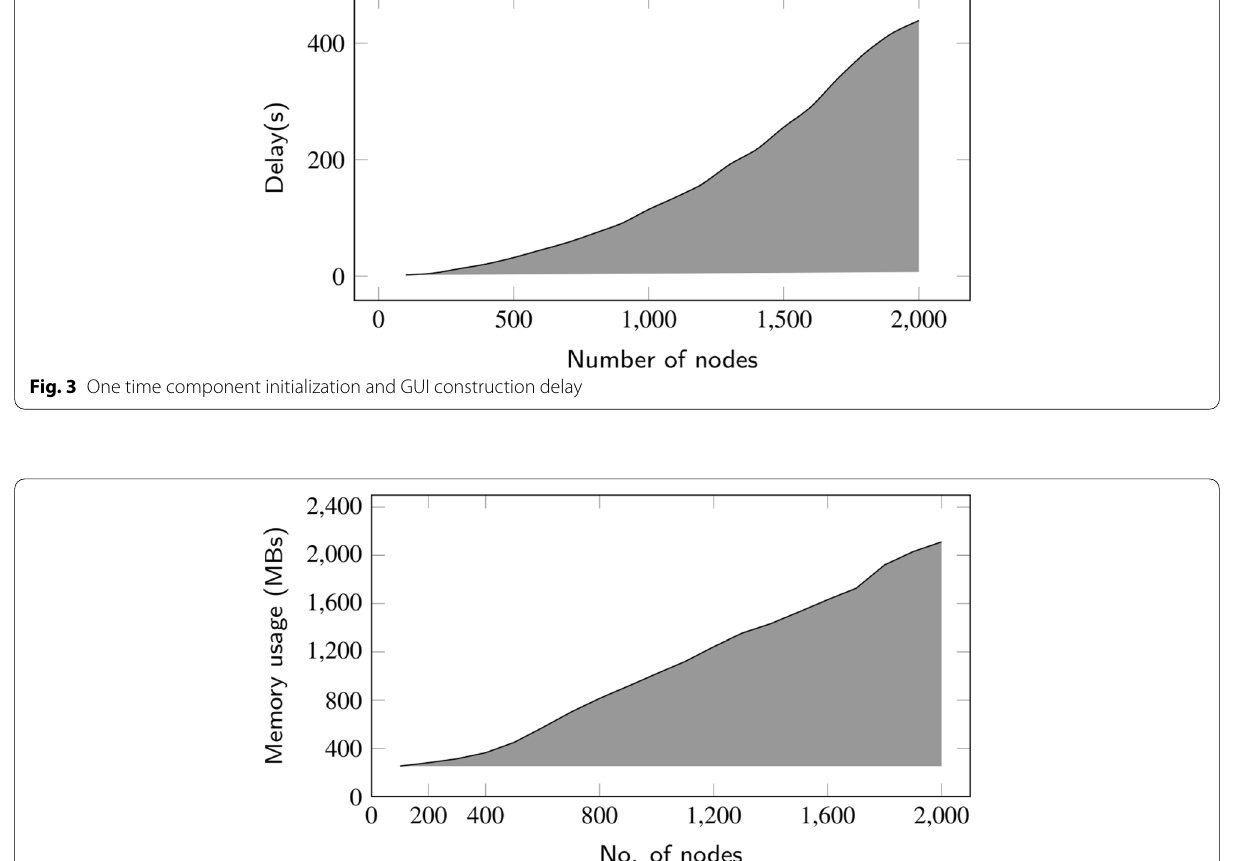
Fig. 4 Memory and CPU usage of the system with respect to number of nodes (IIoT